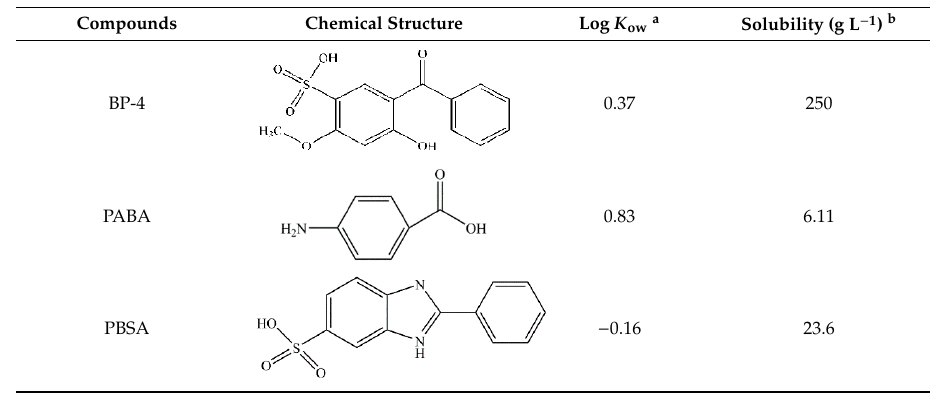
Table 1. Physico-chemical properties of three tested chemicals.